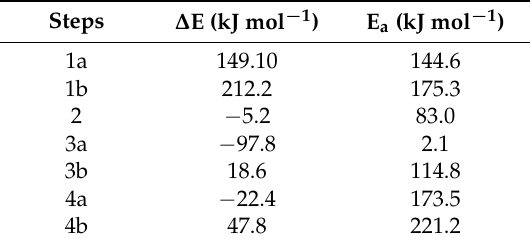
Table 3. The calculated ∆ E and E a for the CH 3 OH synthesis reaction pathways.